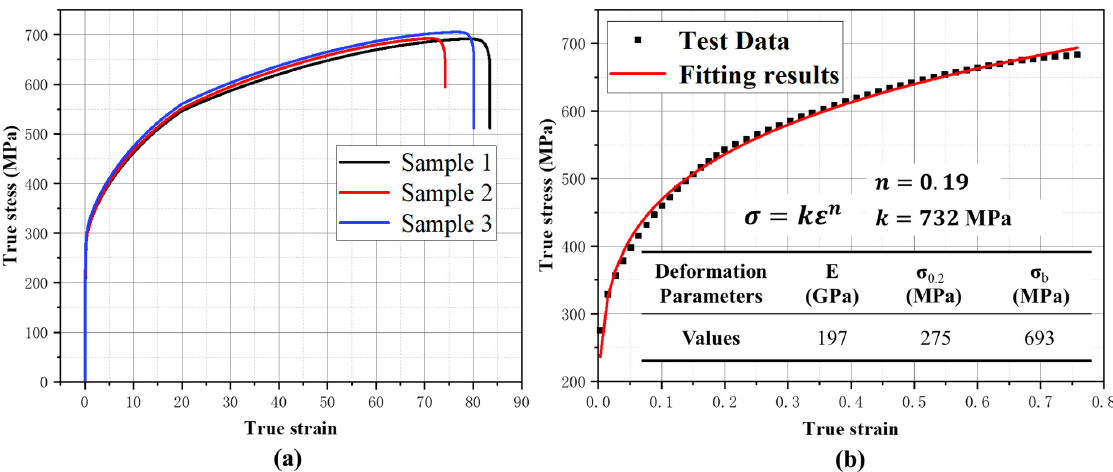
Figure 5. Standard uniaxial tensile test of the SUS304 stainless steel tube: ( a ) true stress–strain curve; ( b ) hardened model of the SUS304 stainless steel tube.